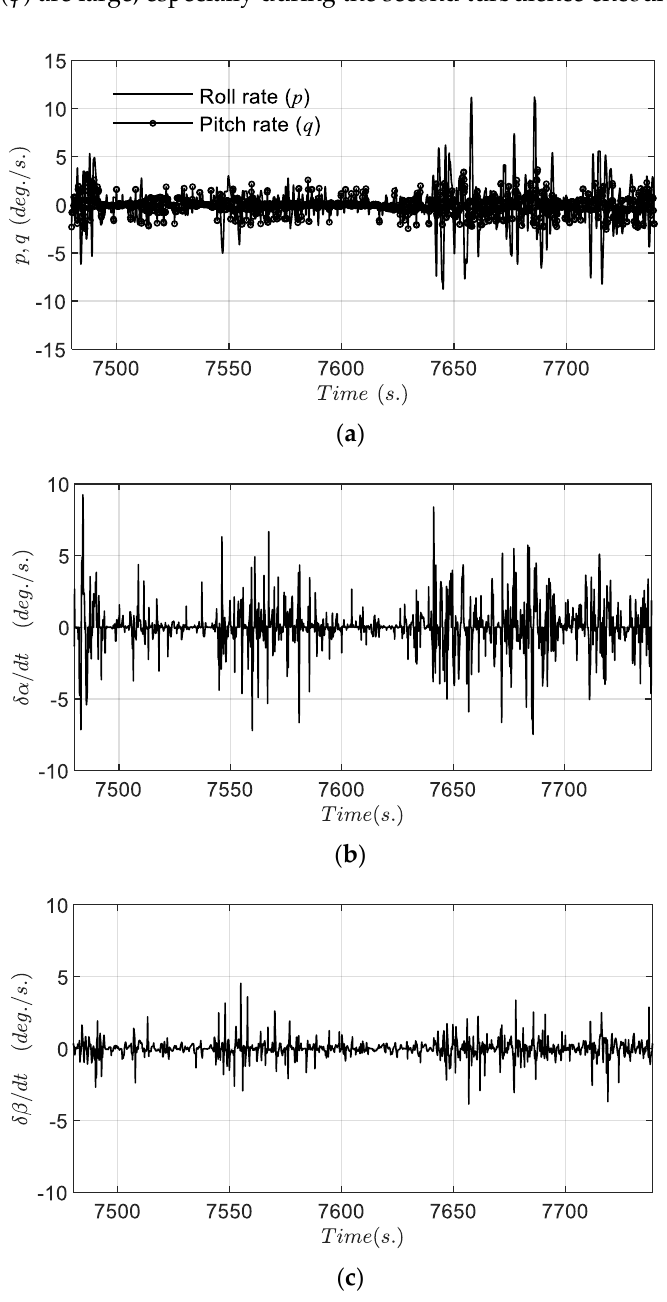
Figure 5. Time history of twin-jet transport aircraft response to dynamic flight motion. ( a ) Time history of the pitch rate ( q ) and the roll rate ( p ); ( b ) Time history of the variable dα/dt ; ( c ) Time history of the variable d β /dt .